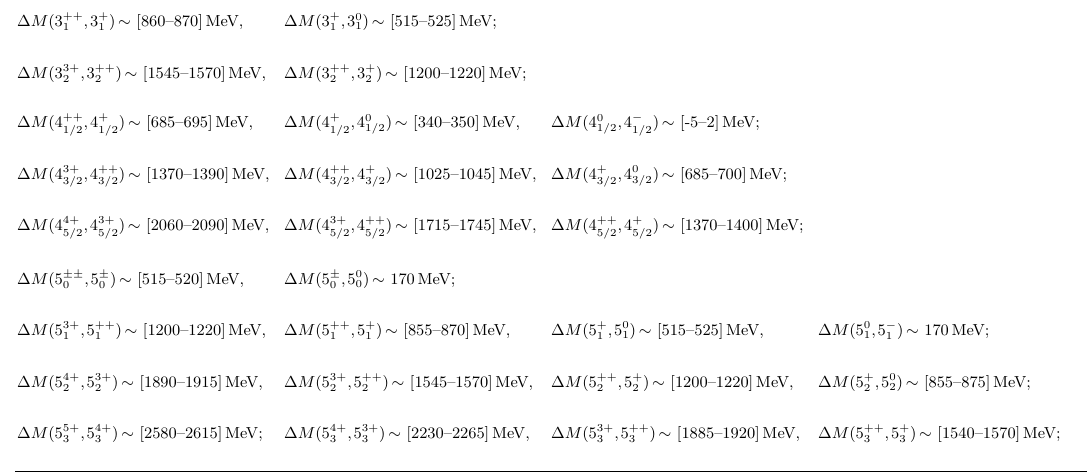
Table 2 . Mass-splittings between the differently charged components of the exotics multiplets.